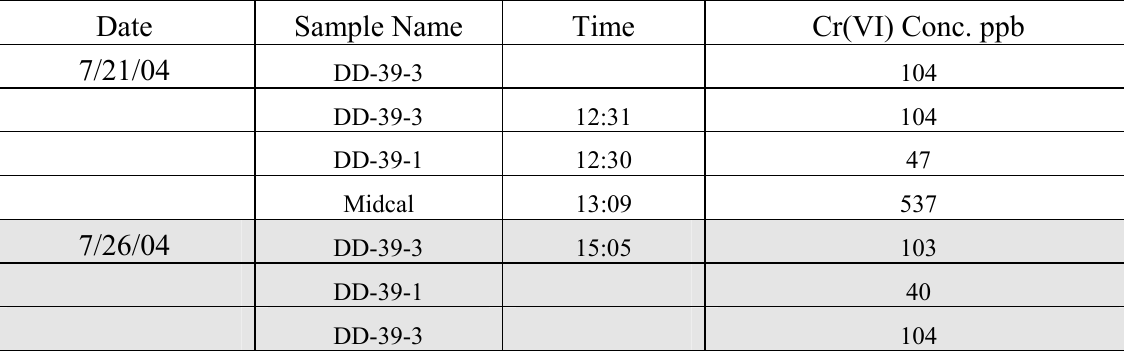
Table 1. Sample results for first hanford deployment July 19-July 26, 2004.